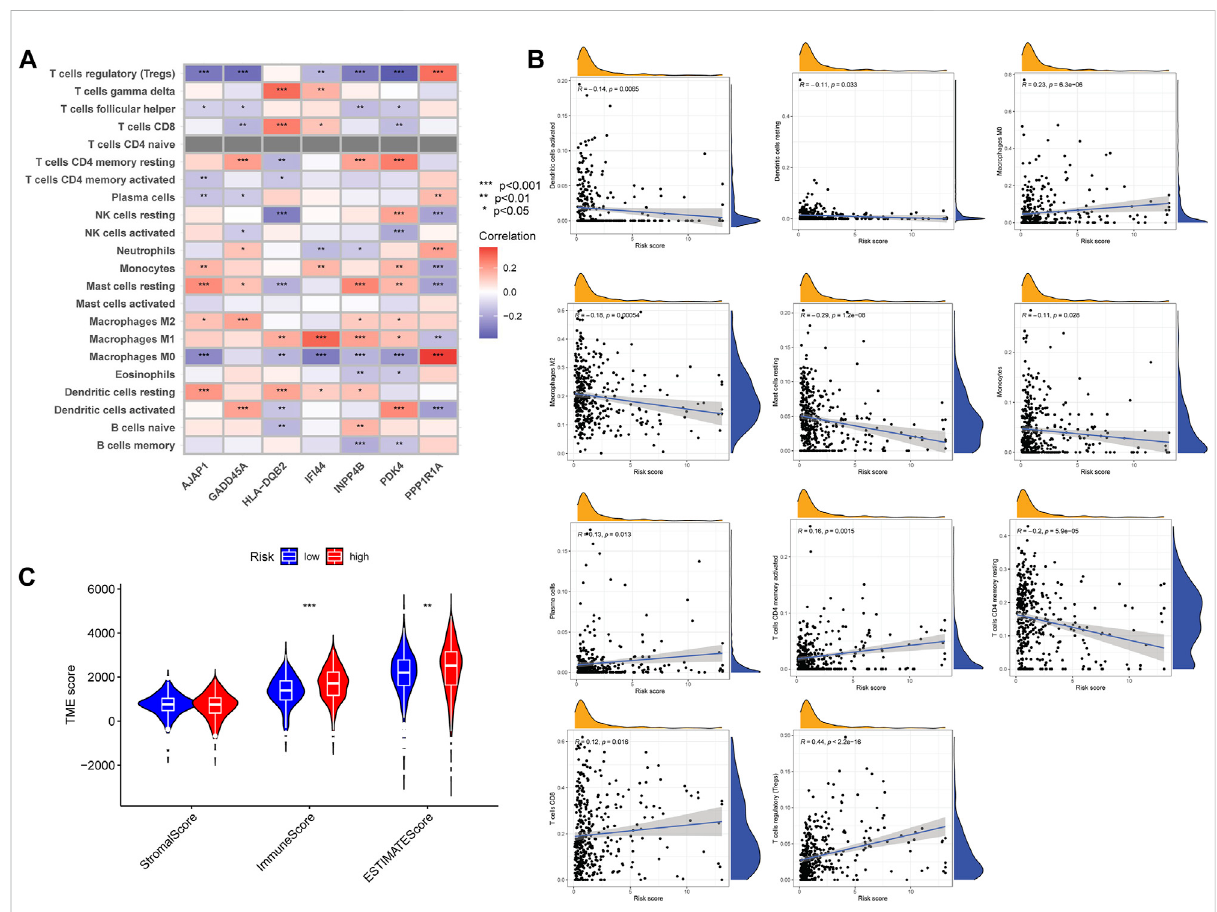
Thecorrelationsbetweenthem7GscoreandTIM. (A) Correlationsbetweenm7Gscoregenesandabundanceofimmunecells. (B) Correlations between the m7G score and immune cell types. (C) The correlations between high- and low-risk group patients and TIM. TIM, tumor immune